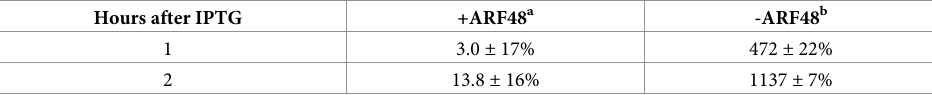
Table 1. ARF48 blocks expression of β -galactosidase. Hours after IPTG +ARF48 a -ARF48 b 1 3.0 ± 17% 472 ± 22% 2 13.8 ± 16% 1137 ± 7% Cells were treated with aTc to induce expression of ARF48 or were mock-treated, and then were treated 5 min later with IPTG to induce expression of β -galactosidase. After culturing for an additional 1 or 2 h, the amount of β - galactosidase enzyme activity (Miller units) in extracts of equal numbers of cells from each culture was determined. a β -galactosidase activity (Miller units) in cells expressing ARF48 b β -galactosidase activity (Miller units) in control cells not expressing